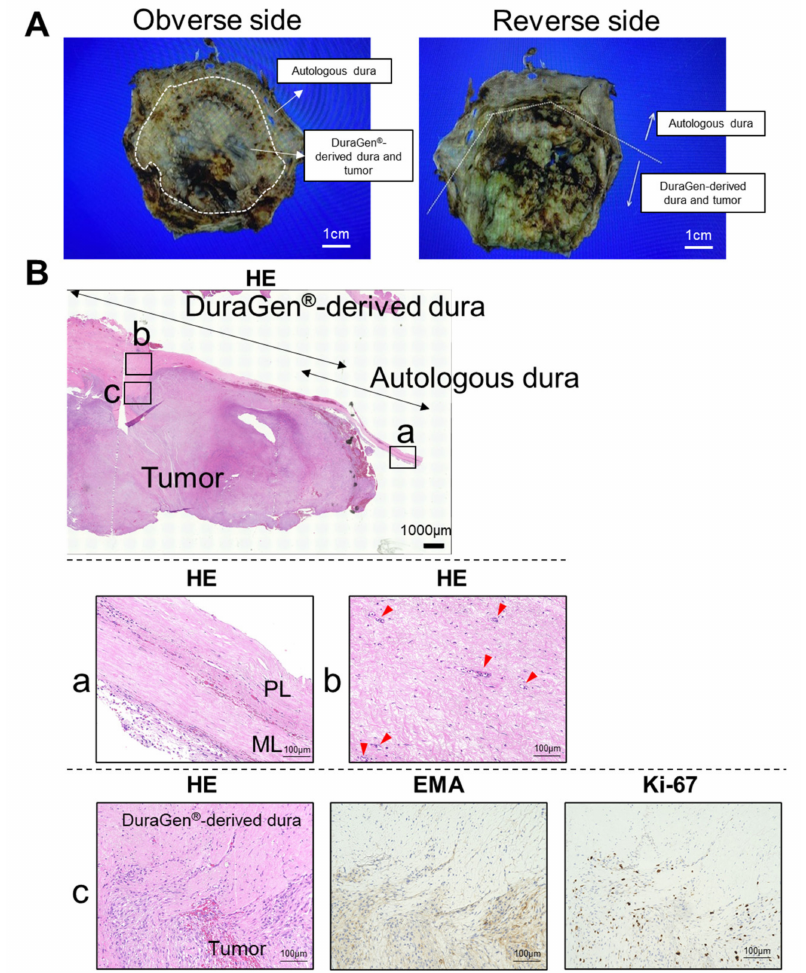
Figure 3. Histopathological finding. ( A ) Macroscopic images of the formalin fixed resected specimen. Left panel: obverse side, right panel: reverse side. ( B ) Coronal section of tumor, autologous dura mater and DuraGen ® -derived dura mater is shown. The meningeal and periosteal layers are clearly observed in the autologous dura mater ( a ). Collagen fibers running regularly and transversely are observed in the DuraGen ® -derived dura mater, resembling the meningeal layer of the autologous dura mater ( b ). Neovascularization is also evident in the DuraGen ® -derived dura mater. Meningioma cell invasion is detected in the DuraGen ® -derived dura mater ( c ). Immunostainings of EMA and Ki-67 are shown. Serial paraffin sections are immunostained and evaluated for each staining (Original magnification, × 20). Red arrowhead: vascular structure. EMA, epithelial membrane antigen;